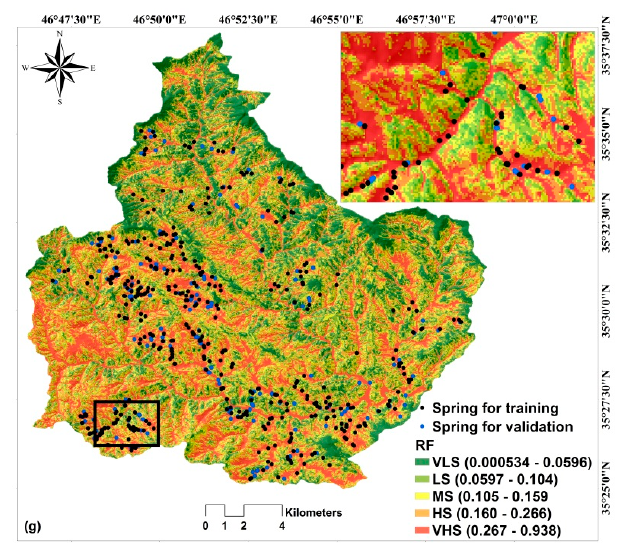
Figure 4. The GSPM using; ( a ) AB–ADTree, ( b ) ADTree, ( c ) SVM, ( d ) SGD, ( e ) LMT, ( f ) LR, and ( g ) RF.